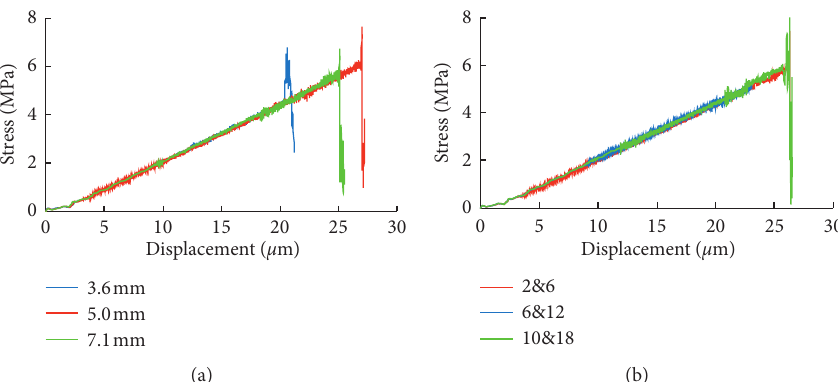
Figure 23: Stress-displacement curves of the center point of the bedding model with different layer thicknesses. (a) Uniformly parallel. (b) Unevenly parallel.